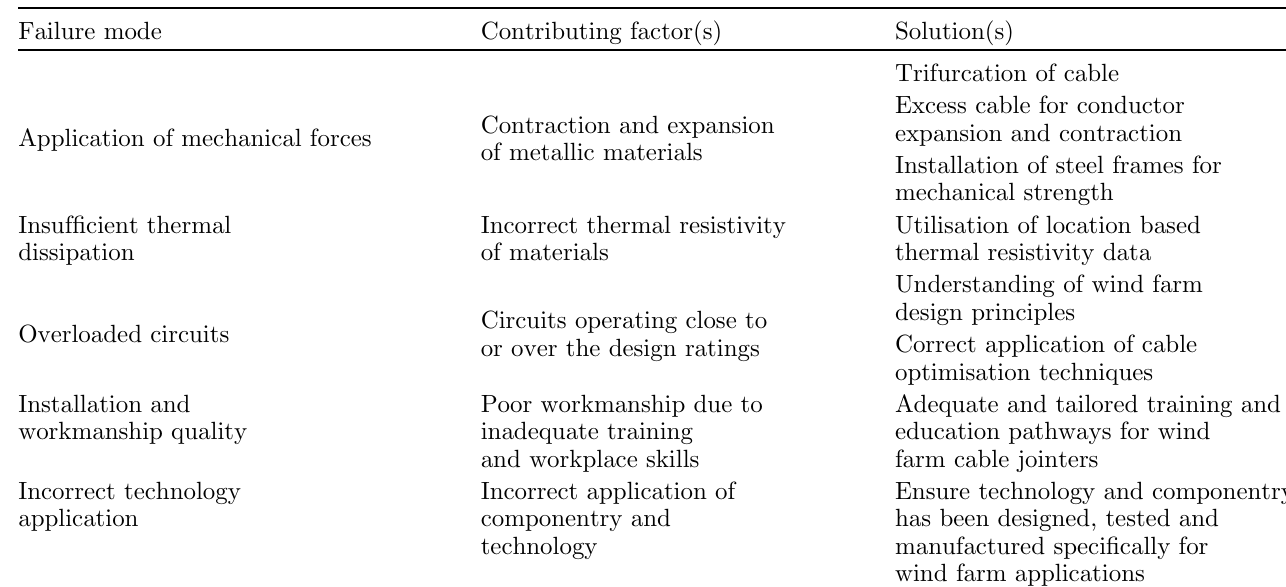
Table 1. Cable joint failure modes, contributing factors and solutions